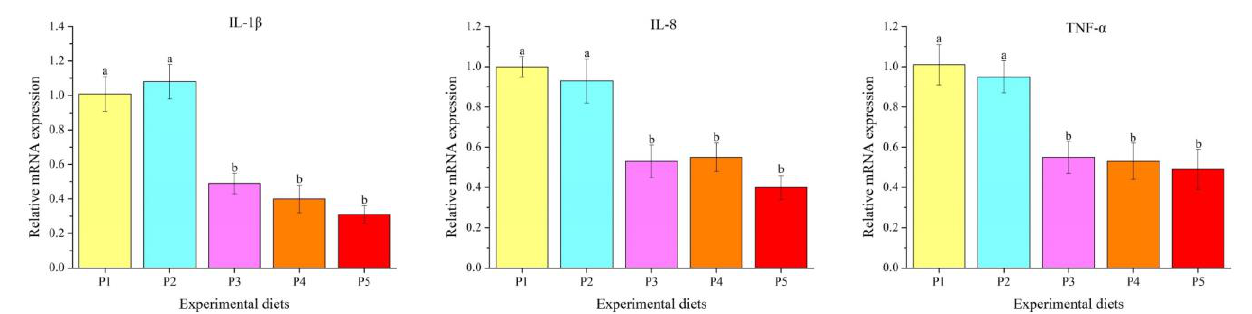
Figure 5. The mRNA levels of inflammation-related genes in the gut of Oncorhynchus mykiss fed experimental diets. Values are presented as mean ± SE, n = 4. Means with different superscripts are significantly different ( p < 0.05). IL- 1β: ANOVA, 0.000; linear, 0.000; quadratic, 0.000. IL-8: ANOVA, 0.001; linear, 0.000; quadratic, 0.000. TNF- α: ANOVA, 0.003; linear, 0.000; quadratic, 0.001.